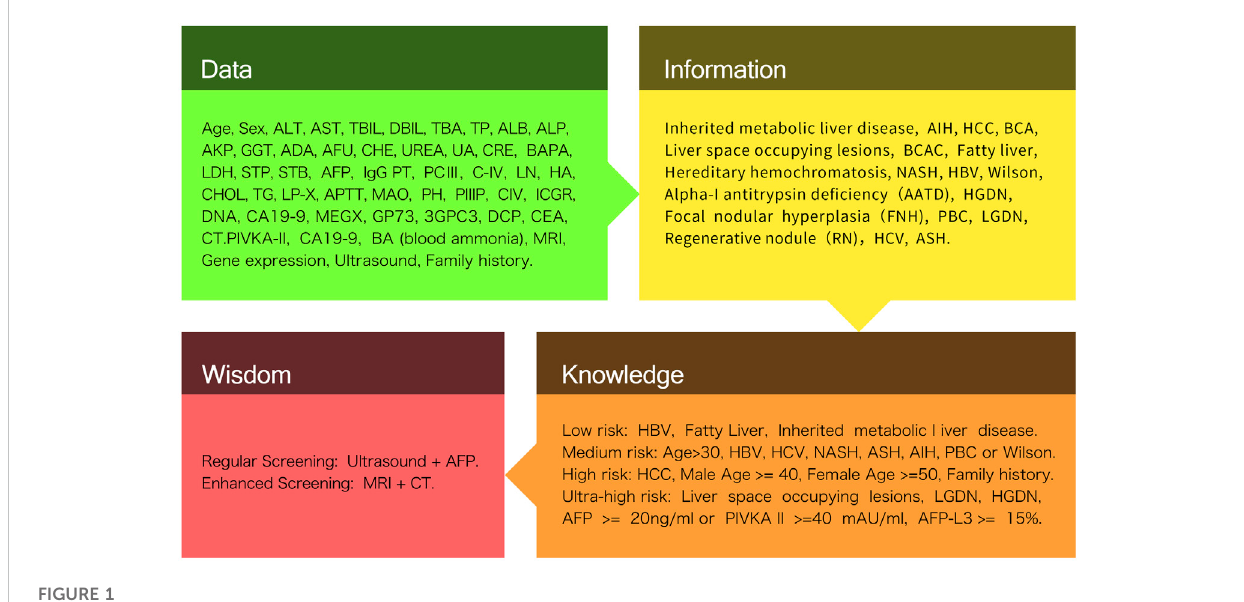
FIGURE 1 DIKW framework system